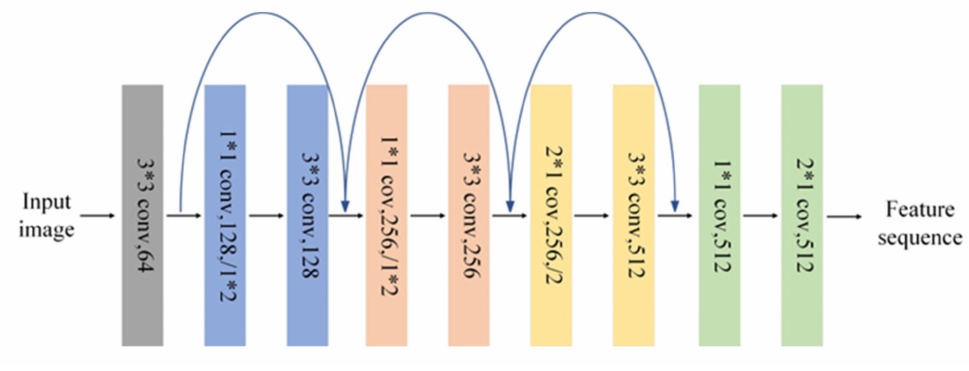
Figure 6. The architecture of the feature